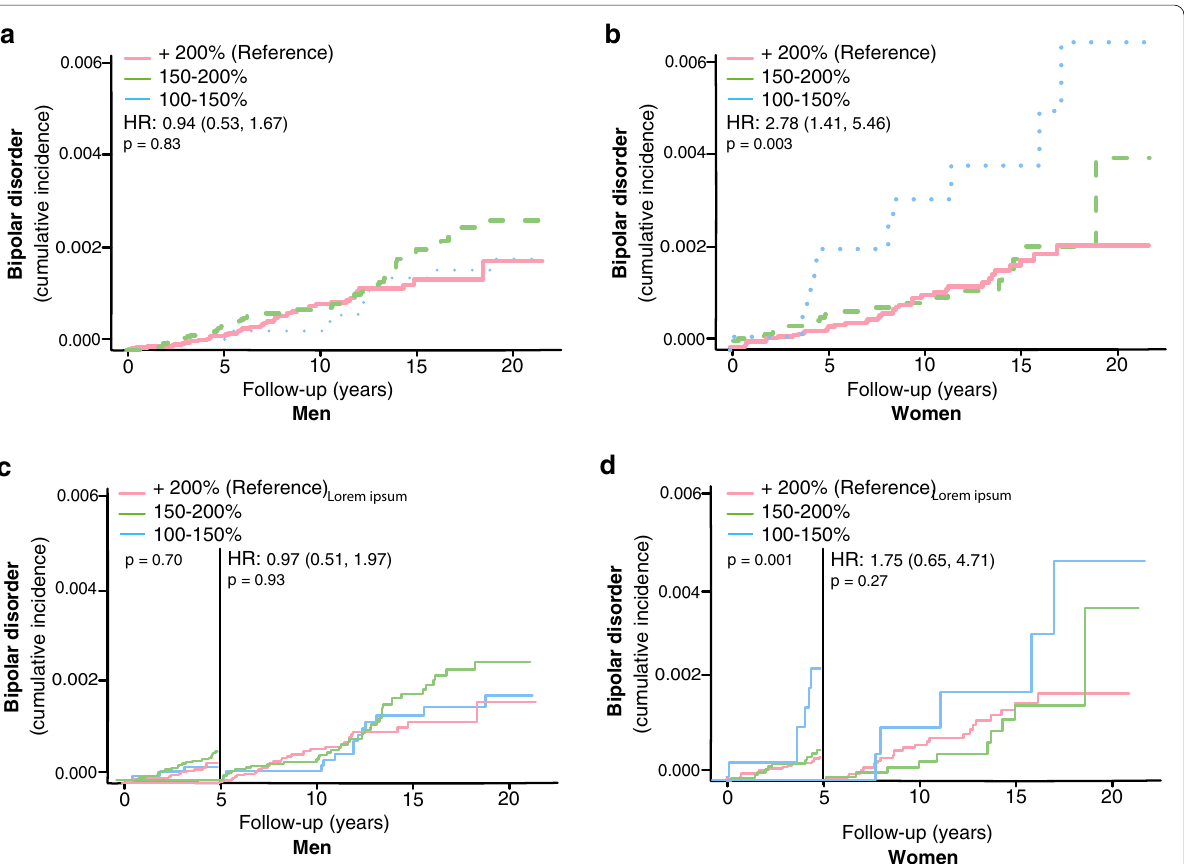
Fig. 3 The impact of ski race finishing time on the risk of developing bipolar disorders in skiers in men ( a ) and women separately ( b ). The impact of ski race finishing time on the risk of developing bipolar disorders more than 5 years after completing the ski race in men ( c ) and women ( d ). HR represents hazard ratios from an unadjusted C ox regression for the fastest (100–150% of winning finishing time) group, using reference